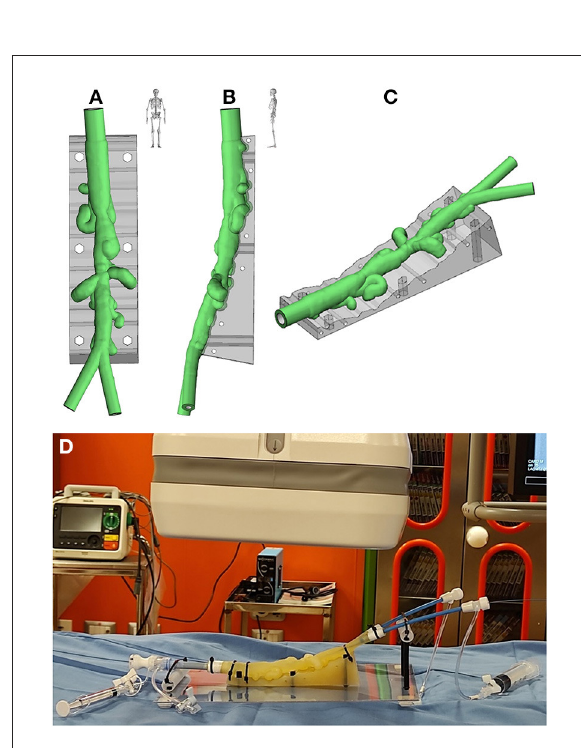
expanded to the nominal diameter of the 9 x 60 mm